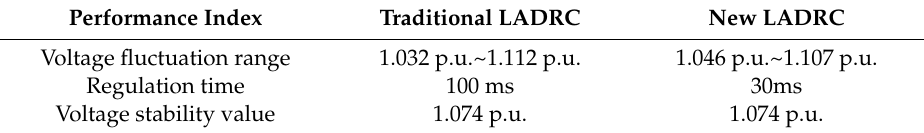
Table 1. Performance index comparison for the grid side voltage rising to 130% case.